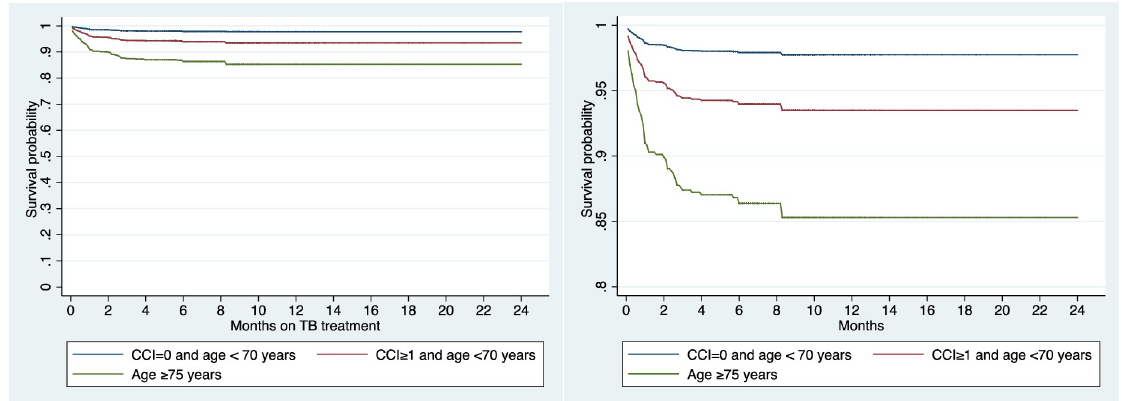
Fig 2. A and B 1 Survival curves of three risk groups among tuberculosis patients alive at diagnosis. 1: Magnified view of the survival curves CCI: Charlson comorbidity index.